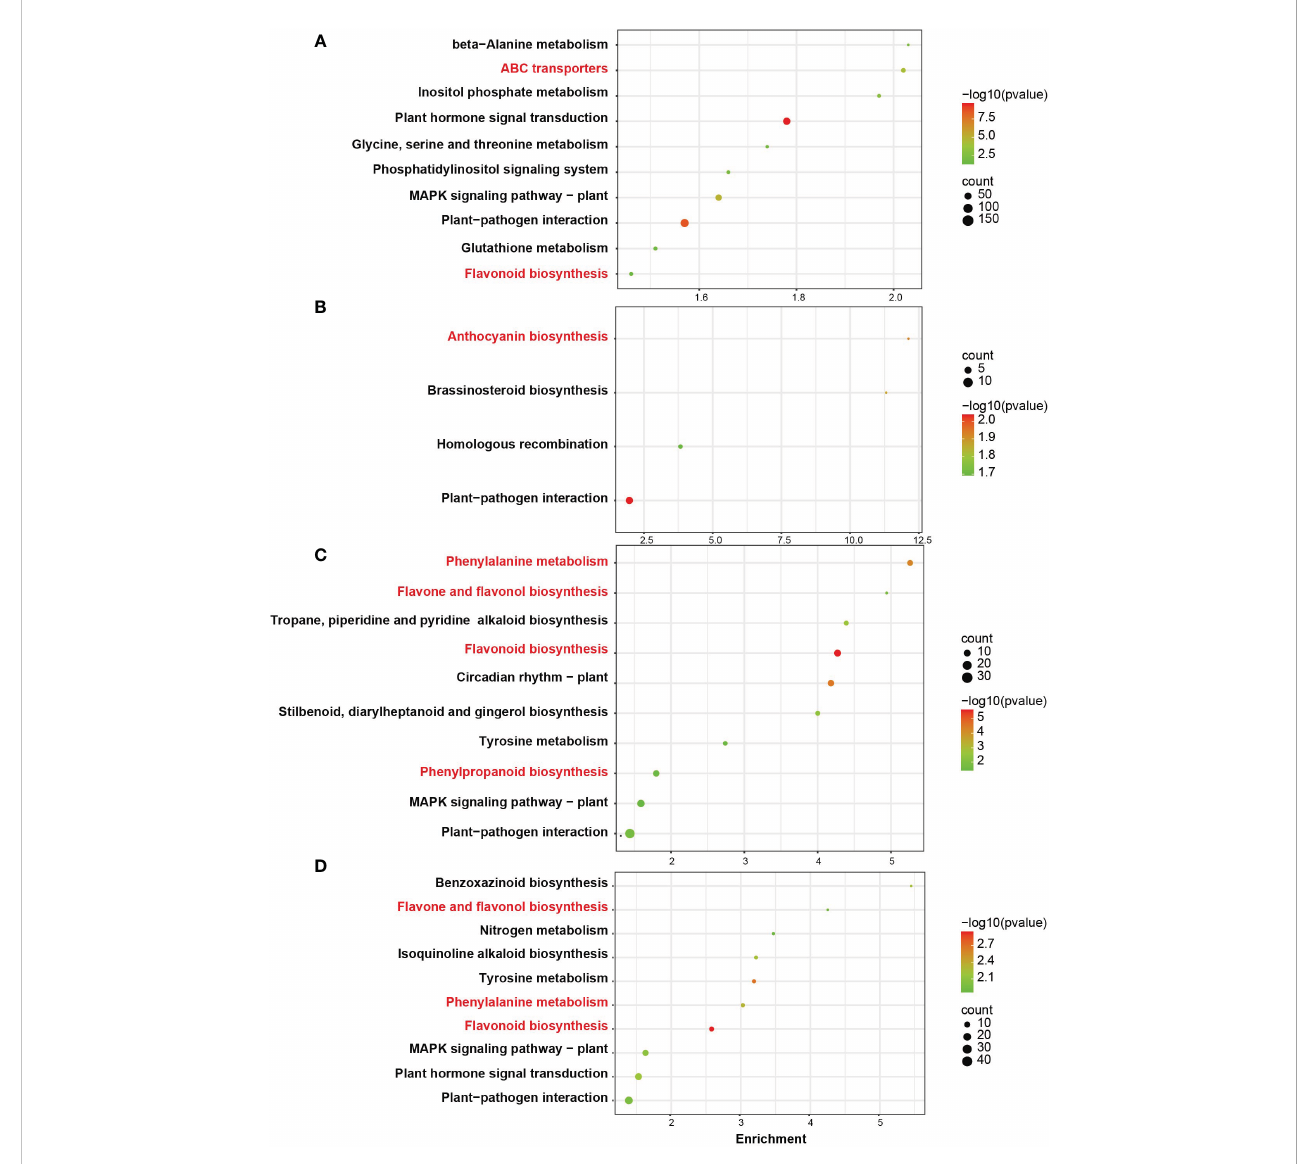
FIGURE 4 KEGGenrichment analysis of differentially expressed genes (DEGs) inGemstone seedless grape that was treated with hyperoside and controlat the B2, B3, B4, and B5 stages. The number ofgenes enriched inthe pathway is represented by the size ofthe circle, and the color corresponds to the size ’ s p-value.Red labels are enriched in the top10sites, P < 0.05,and areassociated with anthocyanin